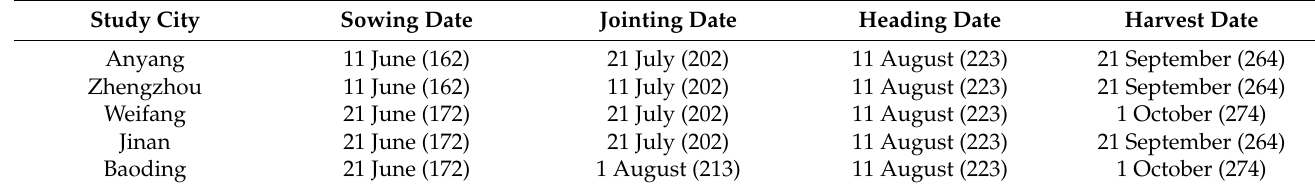
Table 3. The date and ordinal of summer corn growing period planted in five